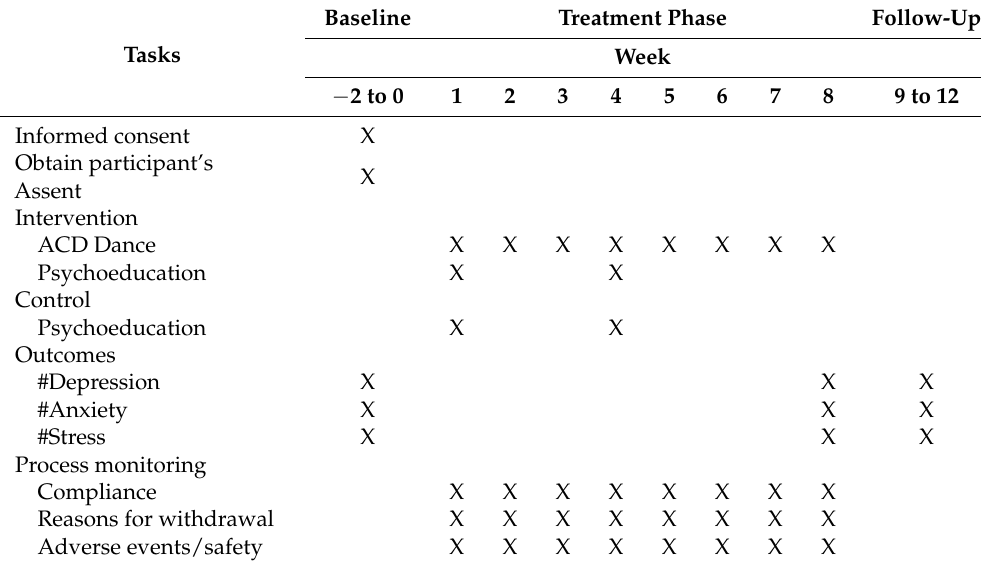
Table 2. Trial Process of the ACD programme. Baseline Treatment Phase Follow-Up Tasks